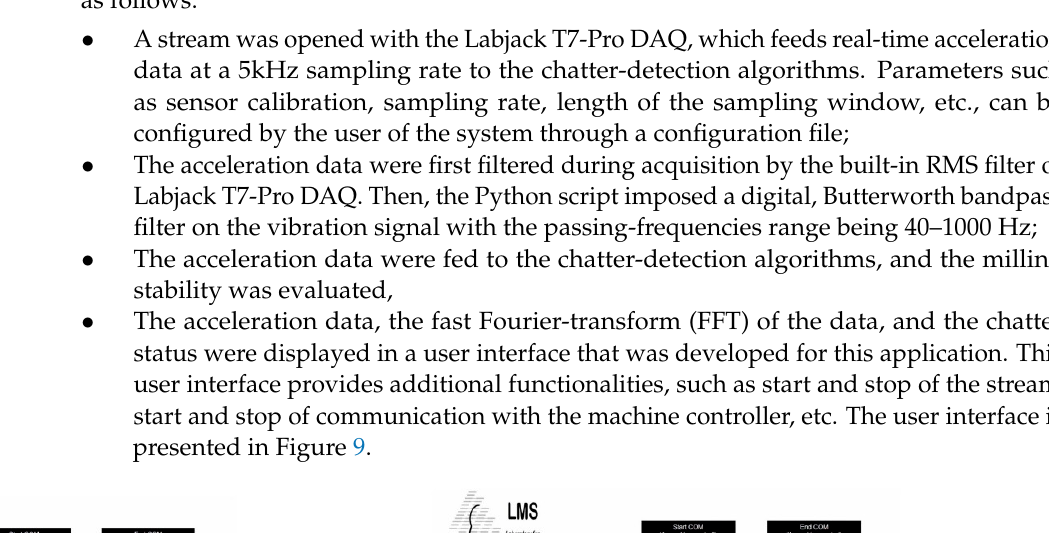
Figure 10. Decomposition of the milling vibration signal generated by the Micromega sensor with VMD.